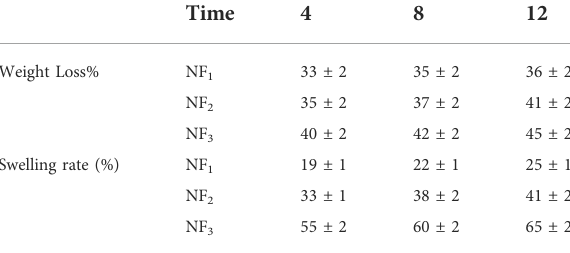
TABLE 3 Weight loss (%) and swelling rate of prepared nano fi